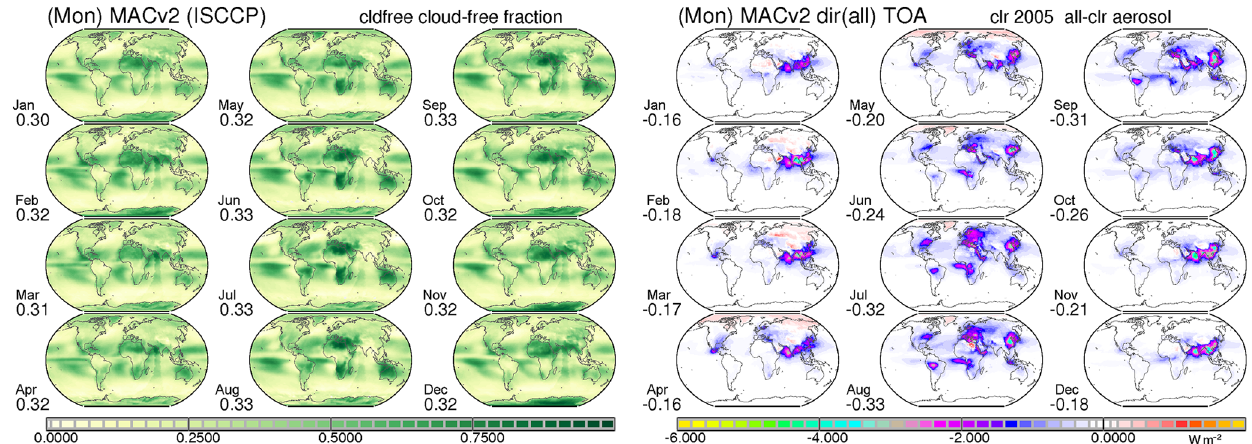
Figure C3. Monthly maps for the clear-sky fraction (left frame) and monthly maps for the present-day clear-sky radiative TOA radiative forcing that contributes to the all-sky forcing.